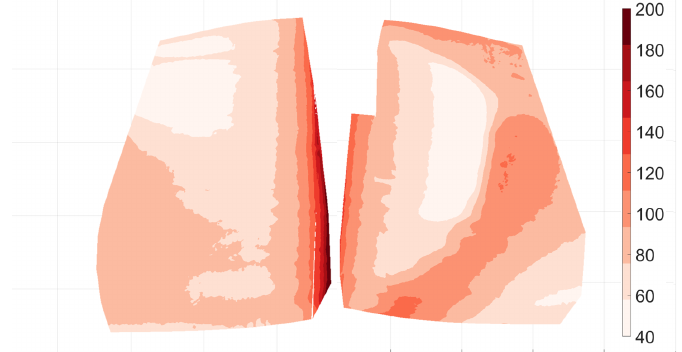
Figure 14. Contours of HTC on pressure ( left ) and suction side ( right ) for flow coefficient φ =